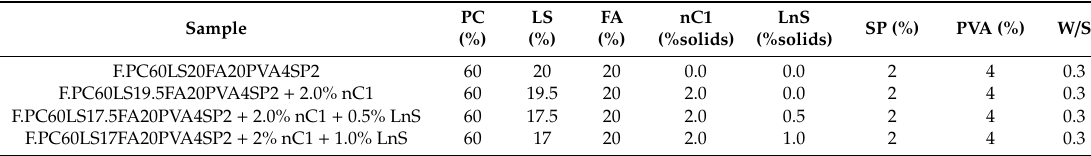
Table 2. nMt and LnS modified fibre reinforced quinary cement paste formulations - Mix proportions % by total mass of solids.